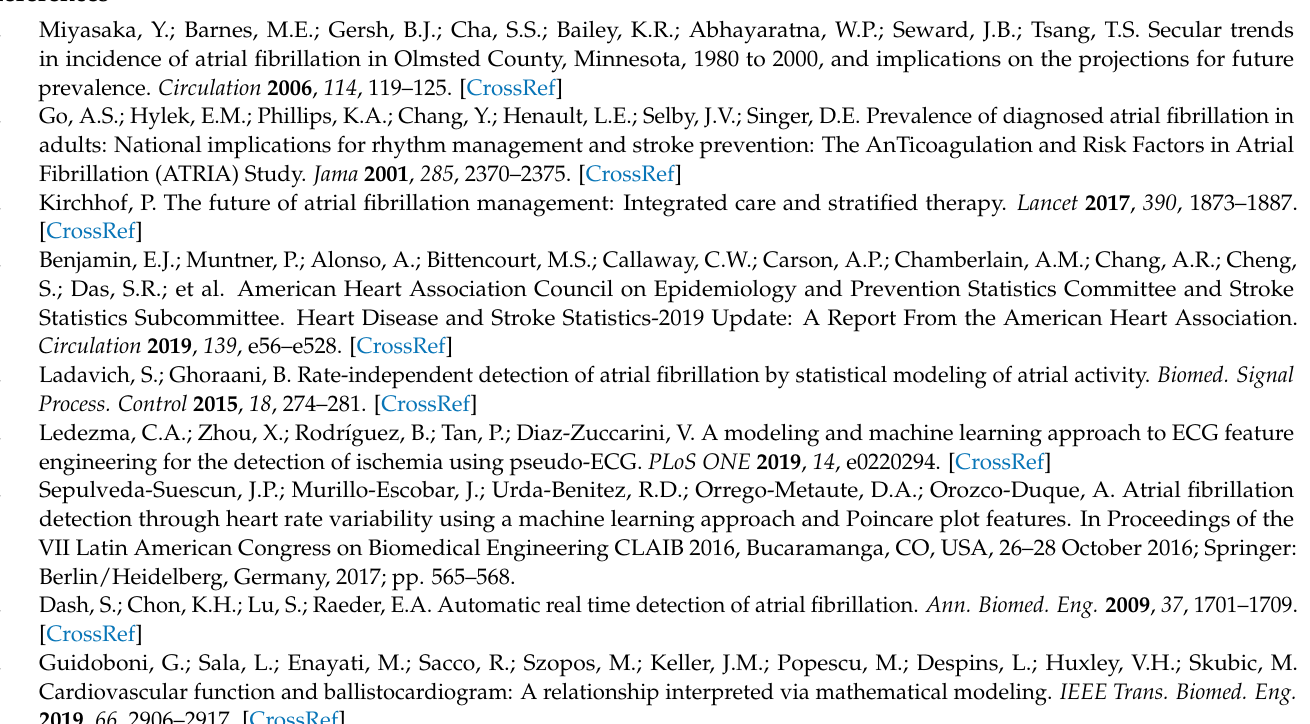
Table A4. AF detection performance based on CTW – RQA features ( n = 2).